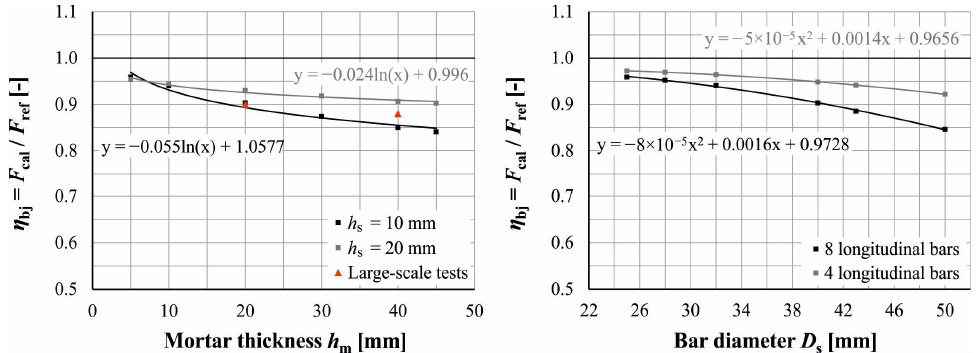
Figure 19. Utilisation of the ultimate load as a function of mortar thickness and steel plate thickness ( left ) and the longitudinal bar diameter ( right ) for square column segments with 28 cm width.